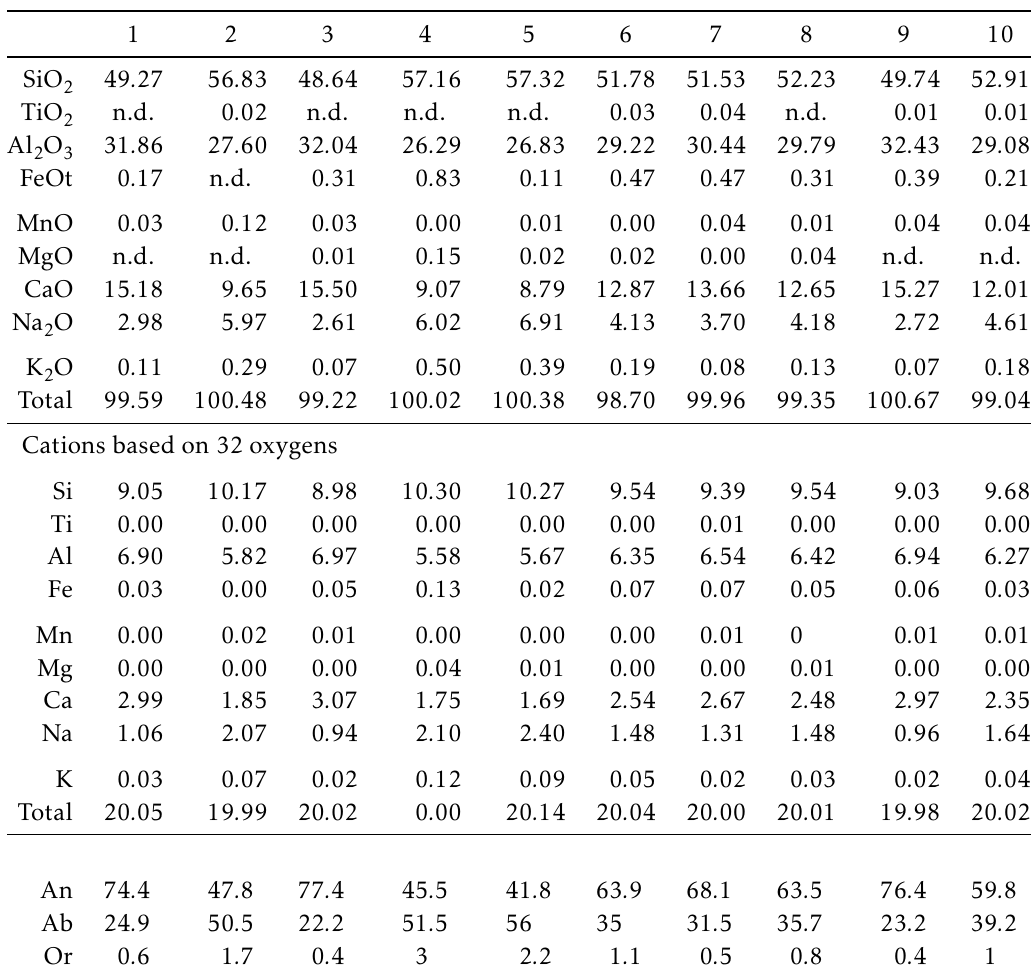
Table 3: Representative major element analyses of plagioclase. n.d. = not detected (below detection limit). Cations based on 32 oxygens (apfu). Comments on occurrence: 1–2: phenocrysts (max and min An%); 3: in association with green hornblende (Hb-Pl clot); 4: microlite; 5: in a metasedimentary xenolith; 6: in the crystalline corona around a metasedimentary xenolith; 7: inclusion in garnet; 8: in the core of the atoll garnet shown in Fig- ure 4D; 9: in the granoblastic core of the composite garnet shown in Figure 6D; 10: in garnet reaction